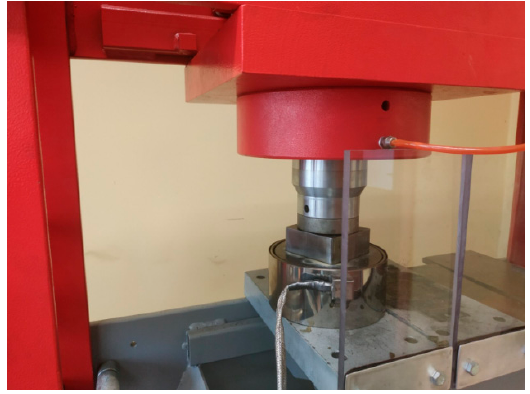
Figure 1. Mechanical press used for sample preparation.